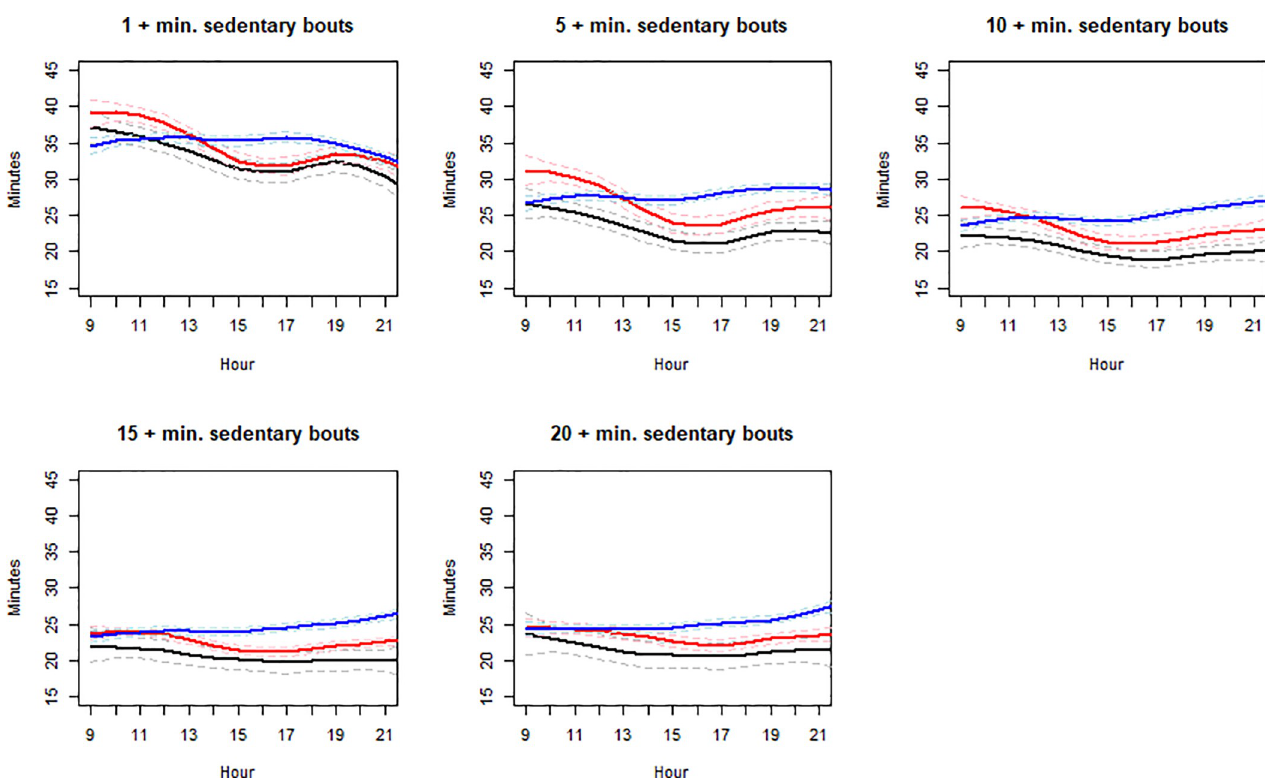
Fig 1. Mean sedentary minutes by bouts in different lengths for each hour between 9 am and 9 pm: Age 14 (black), Age 17 (red), Age 23 (blue). Dashed lines represent the 95% confidence band.